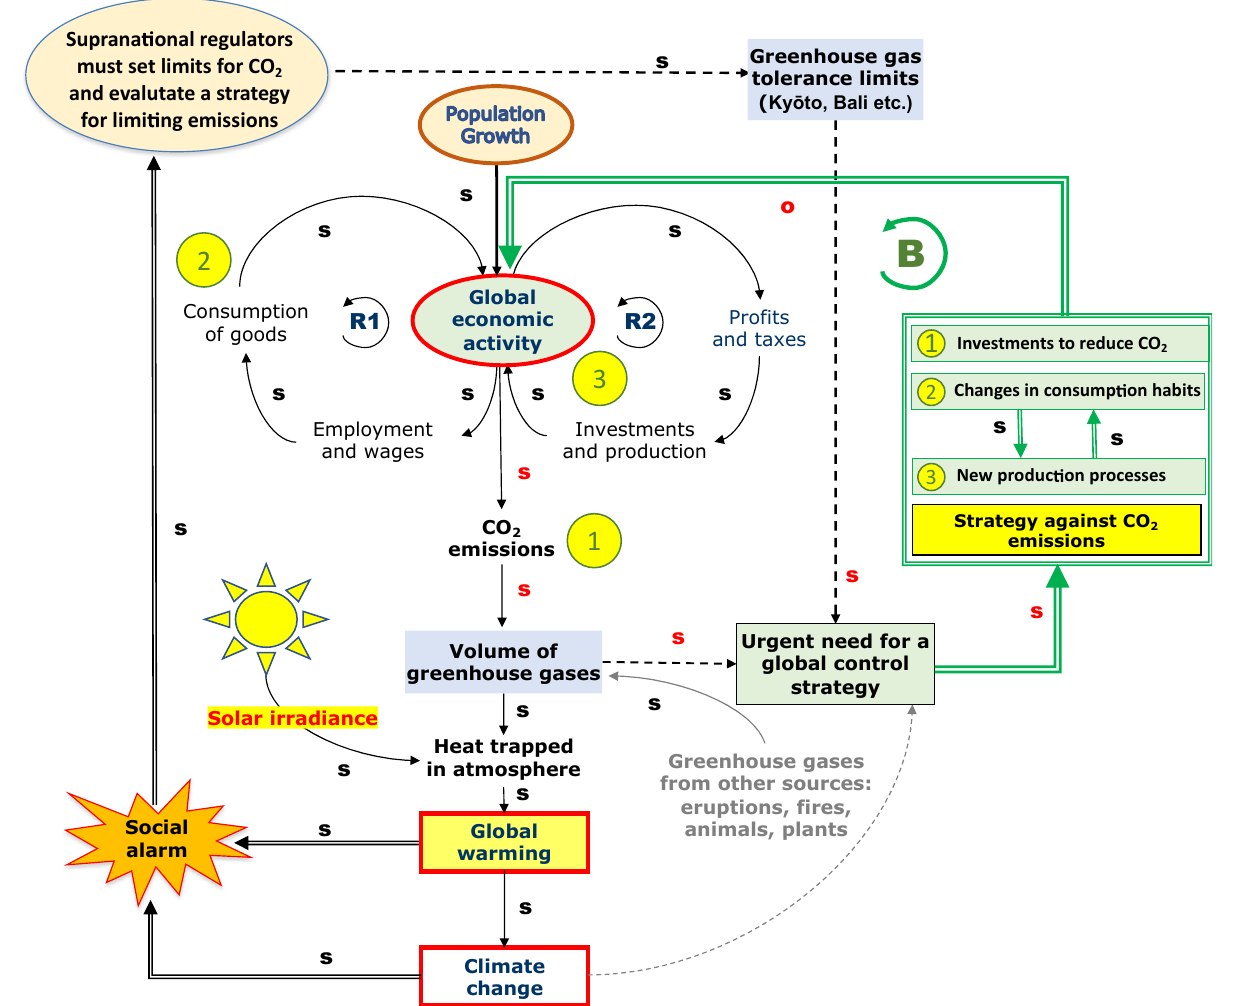
Figure 4. Social alarm and the removal – consumption – production strategy.